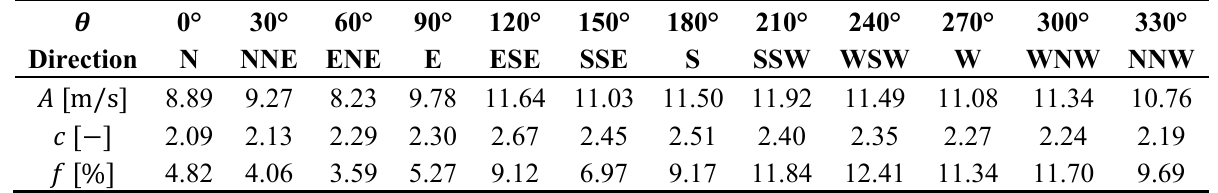
Table 1. Parameters of Weibull distribution and frequency of occurrence for 12